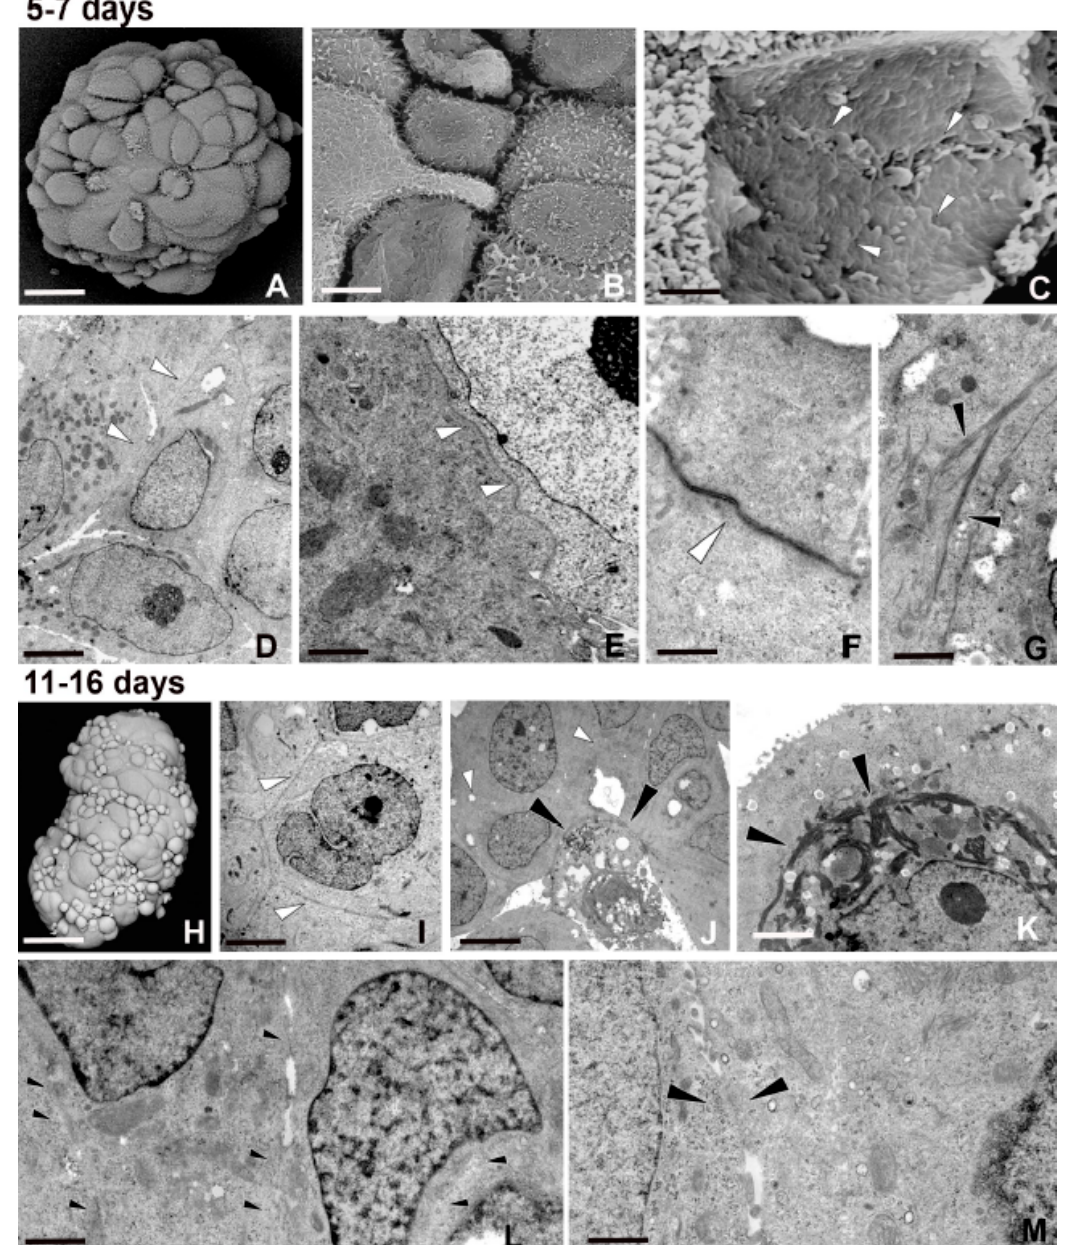
Figure 2. Morphology and behavior of cells during spheroid formation. ( A – G ) Five–seven day spheroid culture. ( A – C ) SEM micrographs of round growing spheroids that grow. Cells are different in shape and size as evident by the enlargement ( B ). The gap junctions ( C ) (arrowheads) among the surfaces of the inner cells are evident after removal of some peripheral ones. Scale bars: ( A ) 30 μ m; ( B ) 5 μ m; ( C ) 0.7 μ m. ( D – G ) TEM analysis. ( D ) Note the high nucleus–cytoplasm ratio. The presence of euchromatic nucleus with voluminous nucleoli reflects an intense metabolic activity. The cells are in close contact ( D – E ) (arrowheads). In the detail ( F ), the unambiguous gap junction profile is shown (arrowhead). ( G ) Many cells are characterized by bundles of actin filaments localized under the cytoplasmic membrane (black arrowheads). Scale bars: ( D ) 3.8 μ m; ( E ) 1.7 μ m; ( F ) 1 μ m; ( G ) 2 μ m. ( H – M ) Eleven–sixteen day spheroid culture. SEM analysis ( H ). Large multicellular spheroids are made of tightly packed cells, different in shape and size, showing various differentiation states. Scale bar: ( H ) 50 μ m. ( I – M ) TEM analysis. Cells are in close contact ( I , J ) and in the inner area of the spheroid, apoptotic cells are evident ( J ) (arrowheads). The presence of thick dark bundles of filaments